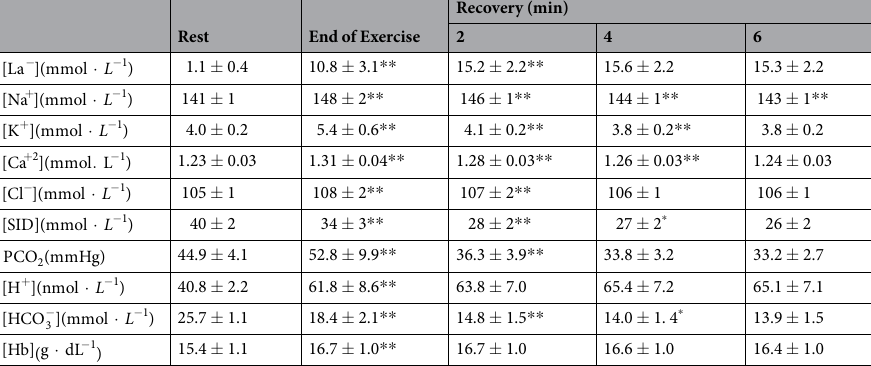
Table 1. Measured blood variables at rest, at the end of exercise, and at 2-, 4- and 6-min recovery. Values are mean ± standard deviation. For all variables there was a significant ( P < 0.001) change over the duration of the experiment. Significant changes from the preceding value are indicated with * for P < 0.05 and ** for P <